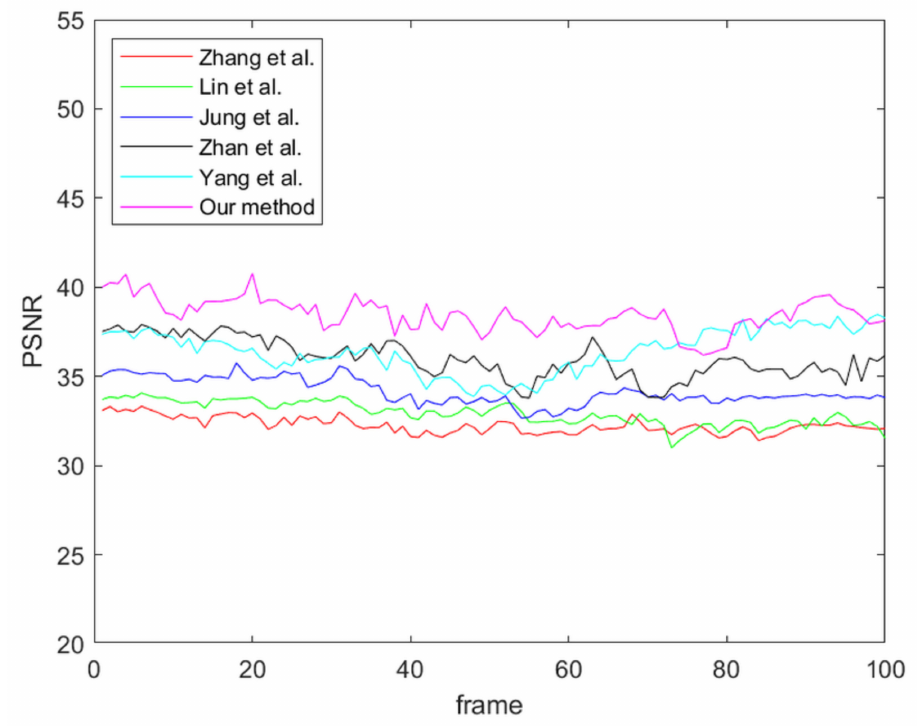
Figure 10. PSNR values for street video clip in comparison of our proposed method, and methods of Zhang et al., Lin et al., Jung et al., Zhan et al., and Yang et